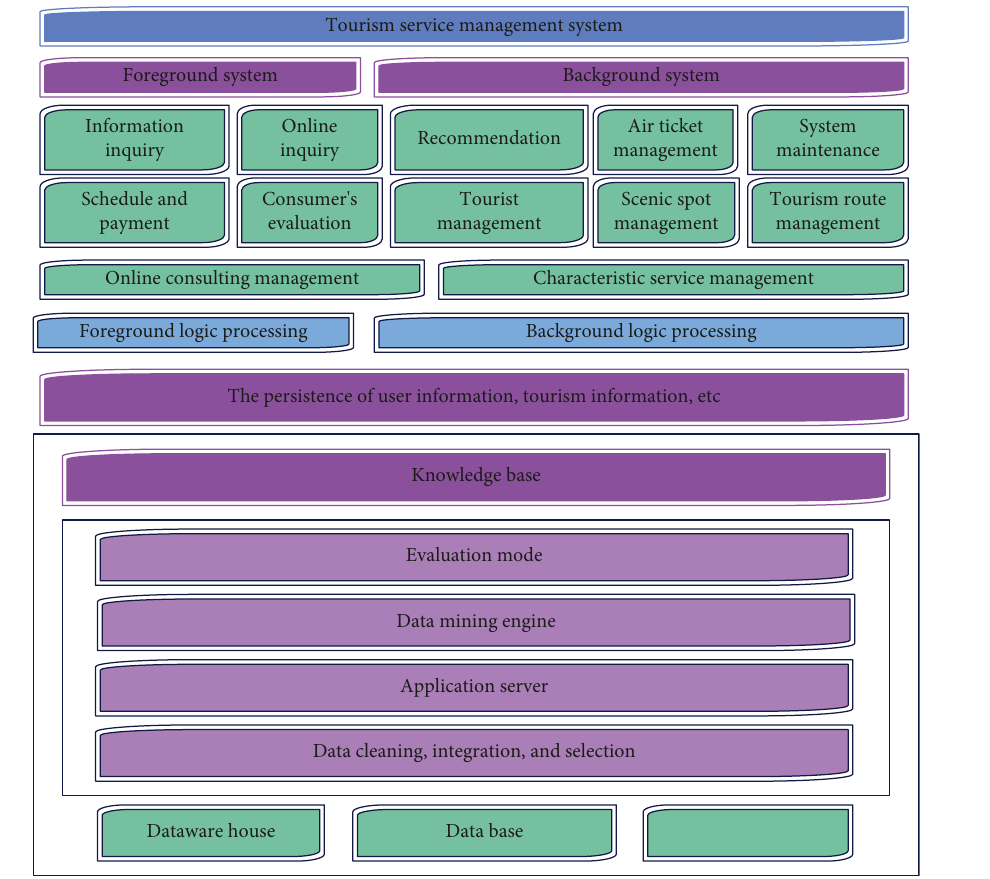
Figure 7: Tourism management system based on data mining.